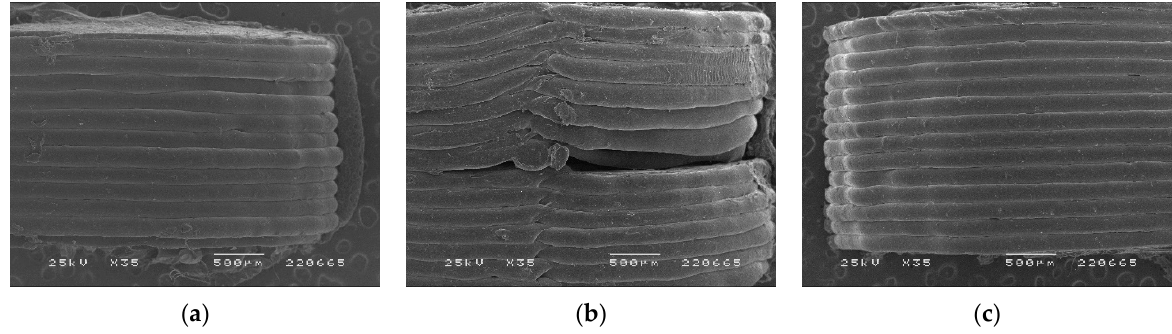
Figure 5. SEM images of printed tablets with ( a ) 0, ( b ) 5 and ( c ) 10 mg of diazepam.